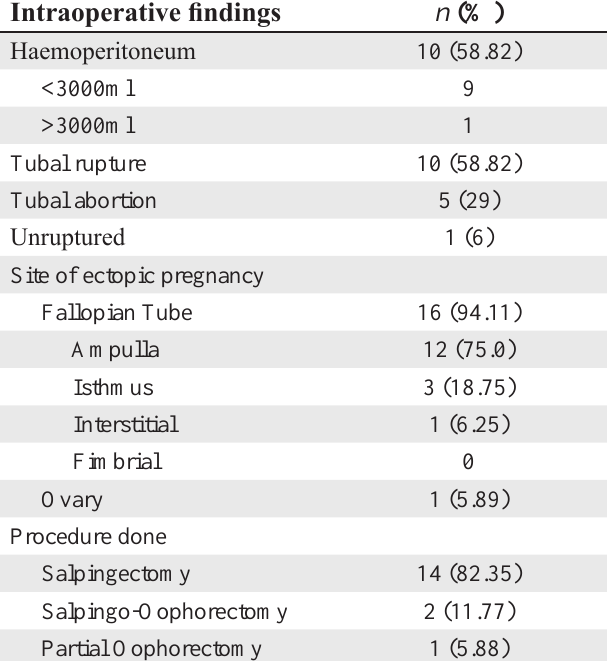
Table 1 : Intraoperative details of women undergoing laparotomy